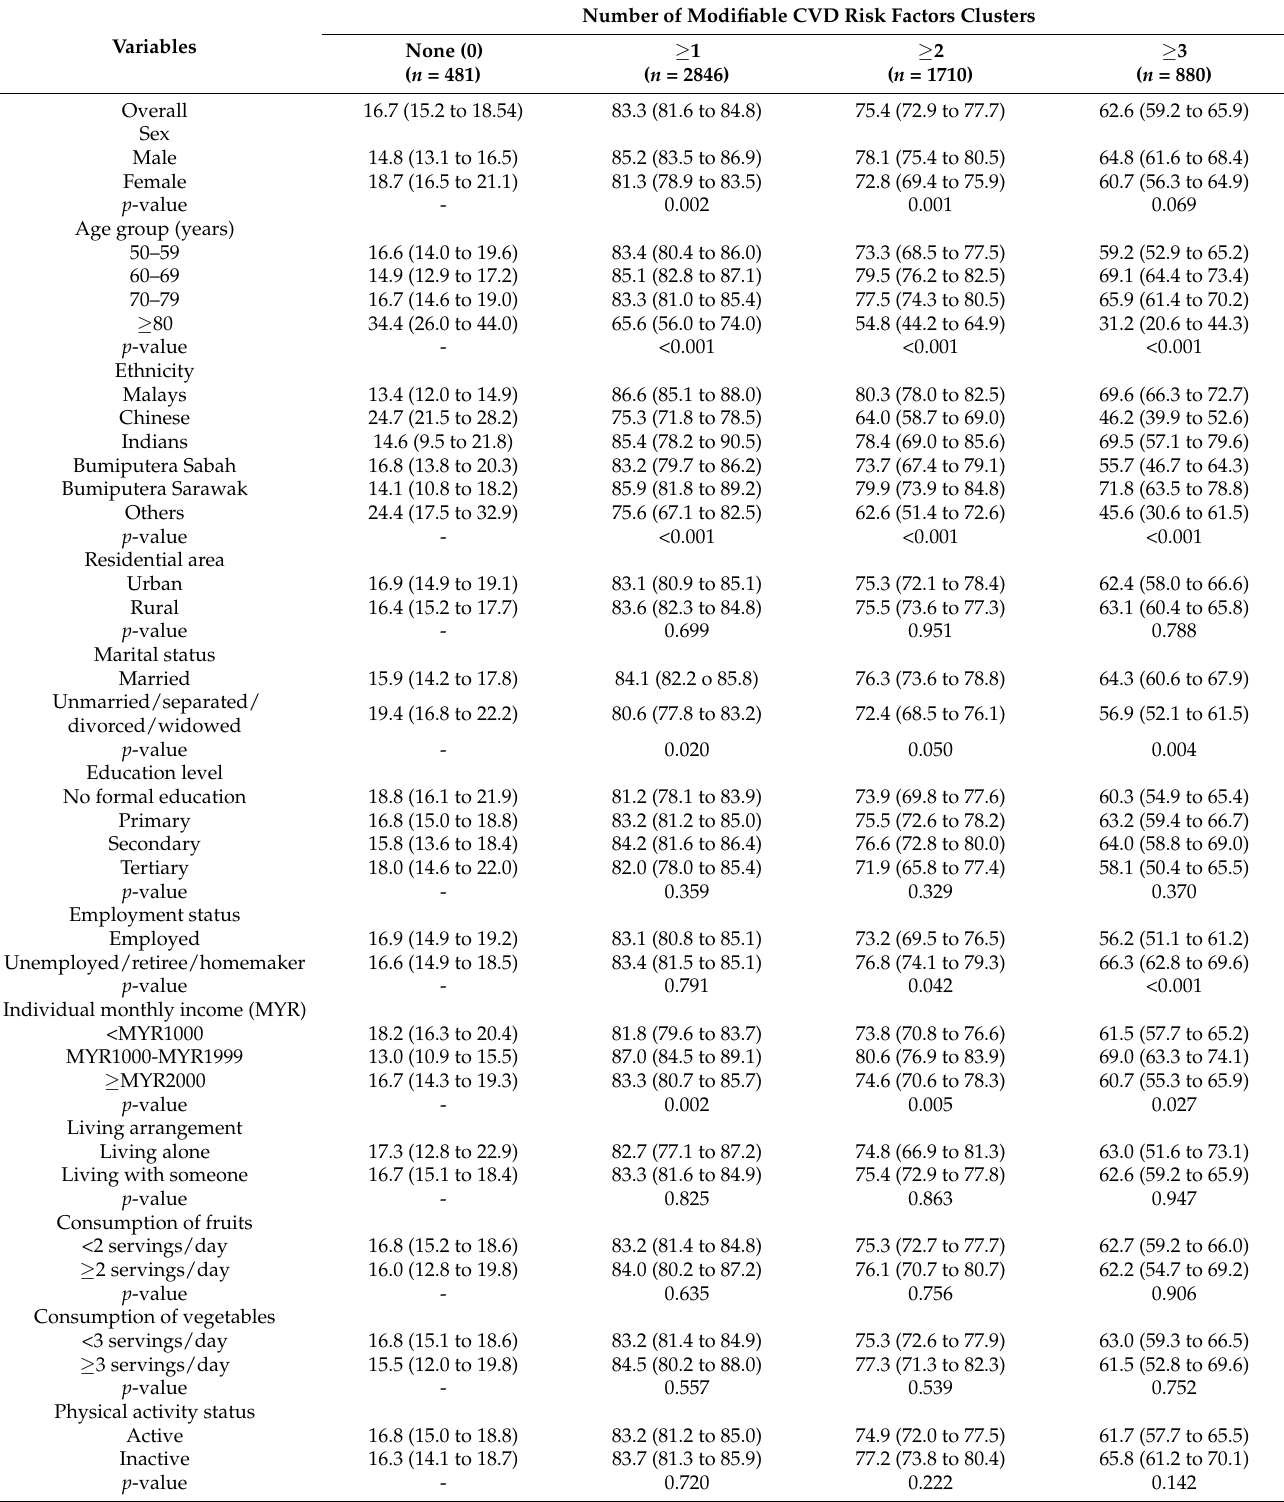
Table 3. The prevalence (95% CI) with different numbers of modifiable cardiovascular disease (CVD) risk factors.